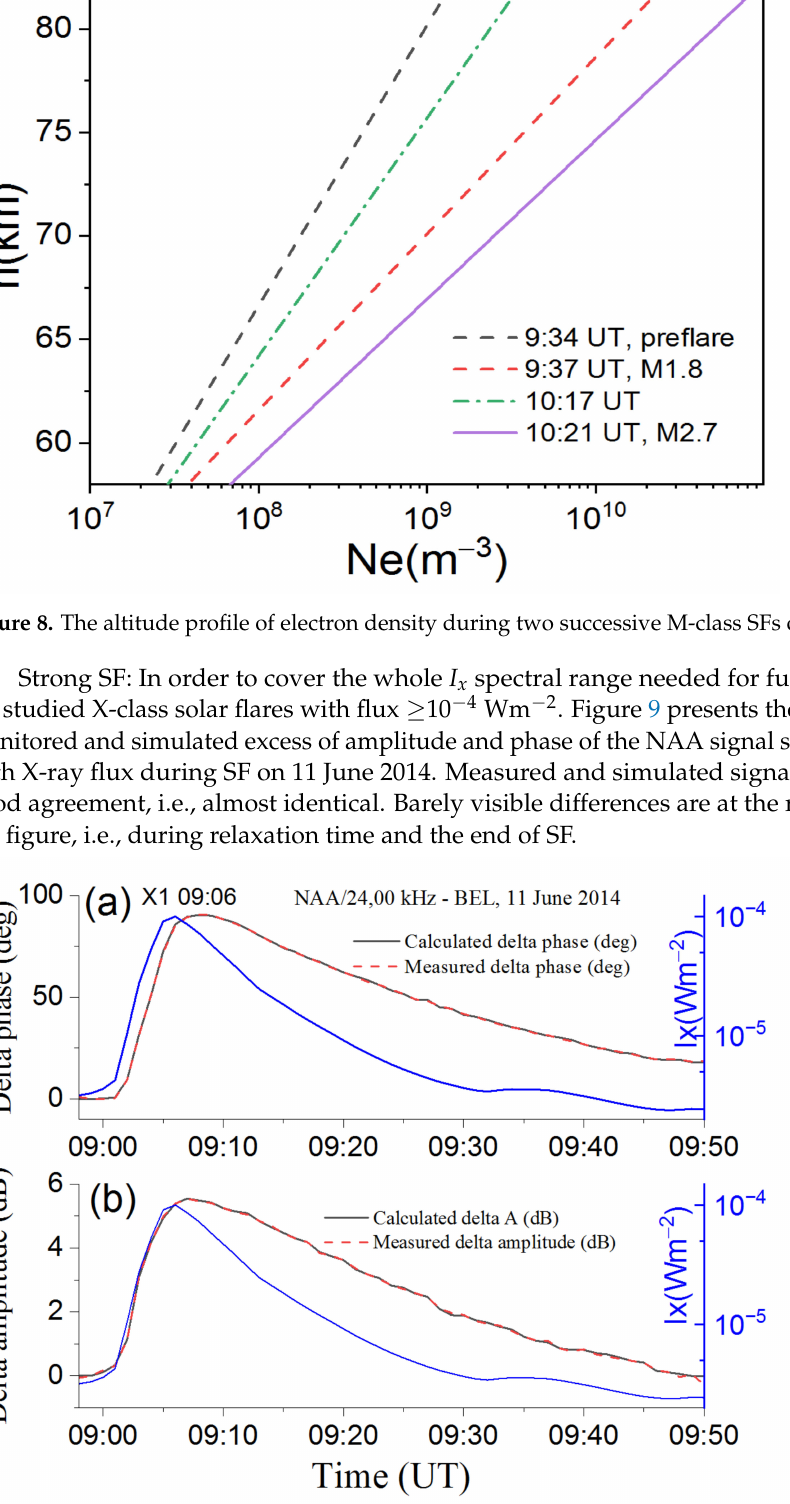
Figure 9. Time variation of X-ray irradiance (on the right axes), NAA/24.00 kHz signal phase ( a ) and amplitude ( b ) enhancement during M1.0 (09:06 UT) events on 11 June